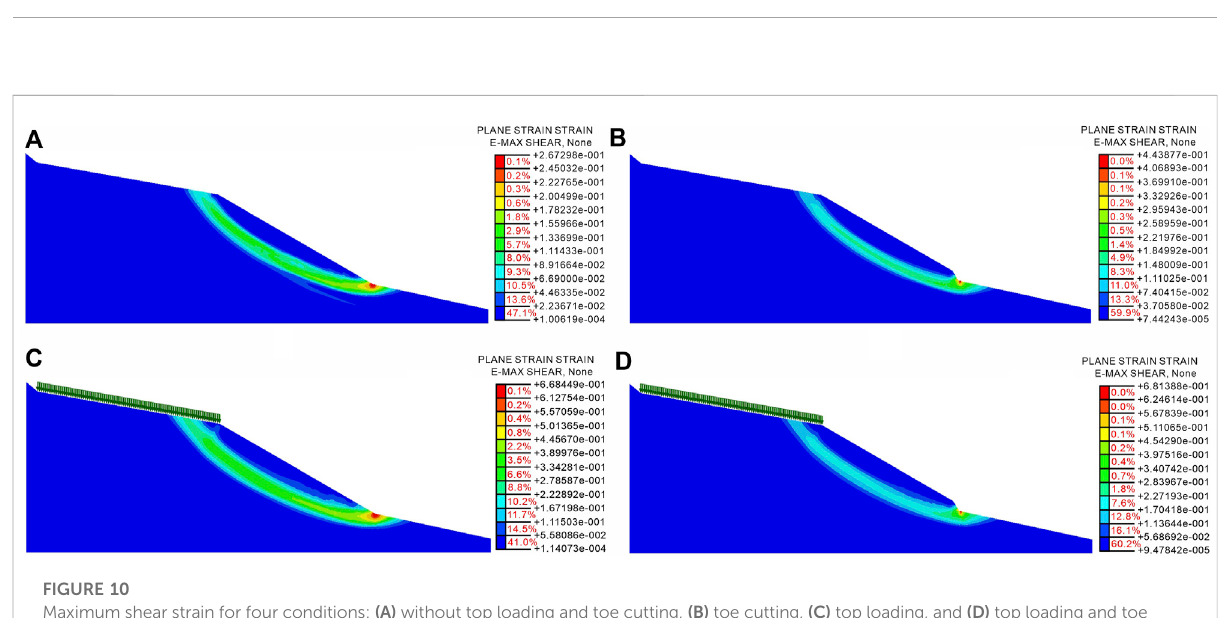
FIGURE 10 Maximum shear strain for four conditions: (A) without top loading and toe cutting, (B) toe cutting, (C) top loading, and (D) top loading and toe